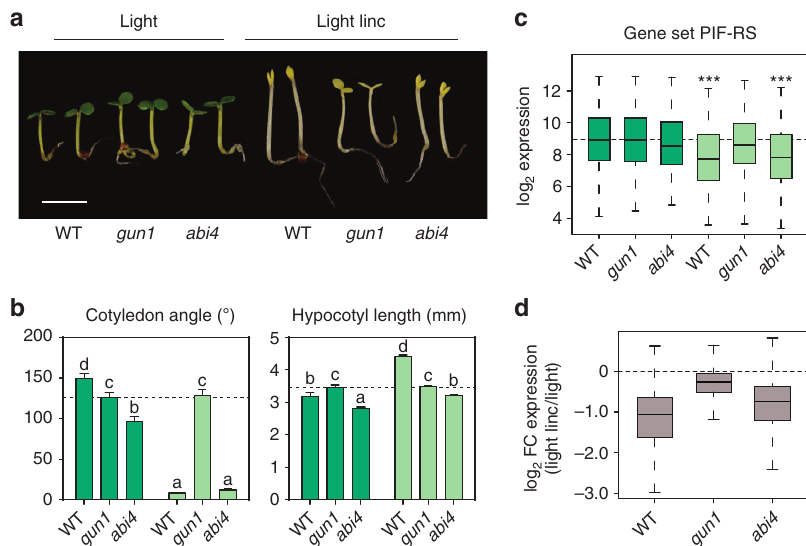
Figure 3 | GUN1 mediates the RS that antagonizes PIF-regulated gene expression. ( a ) Mutants in GUN1 partially deetiolate in the light in the presence of lincomycin, whereas response of mutants in ABI4 responded more similar to WT. WT, abi4 and gun1 seedlings were grown for 3 days in white light in the absence (Light) or presence (Light linc) of lincomycin. Scale bar, 2.5mm. ( b ) Cotyledon angle and hypocotyl length of seedlings grown as in a. Error bars represent the s.e.m. of two independent experiments, each time sampling ( n Z 25). Different letters denote statistically significant differences among means by Tukey-b test ( P o 0.05). ( c ) Lincomycin-induced repression in gene expression in the light of the 343 genes in ‘Gene-Set PIF-RS’ is blocked in gun1 . Expression of genes in ‘Gene-Set PIF-RS’ in WT, abi4 and gun1 in the absence (dark green) and presence (light green) of lincomycin. Statistically significant differences from WT light by heteroscedastic t -test are indicated (*** P o 0.001). ( d ) Fold-change expression in the light in the presence (Light linc) with respect to absence (Light) of lincomycin in WT, abi4 and gun1 seedlings. Data for c , d were obtained from ref.